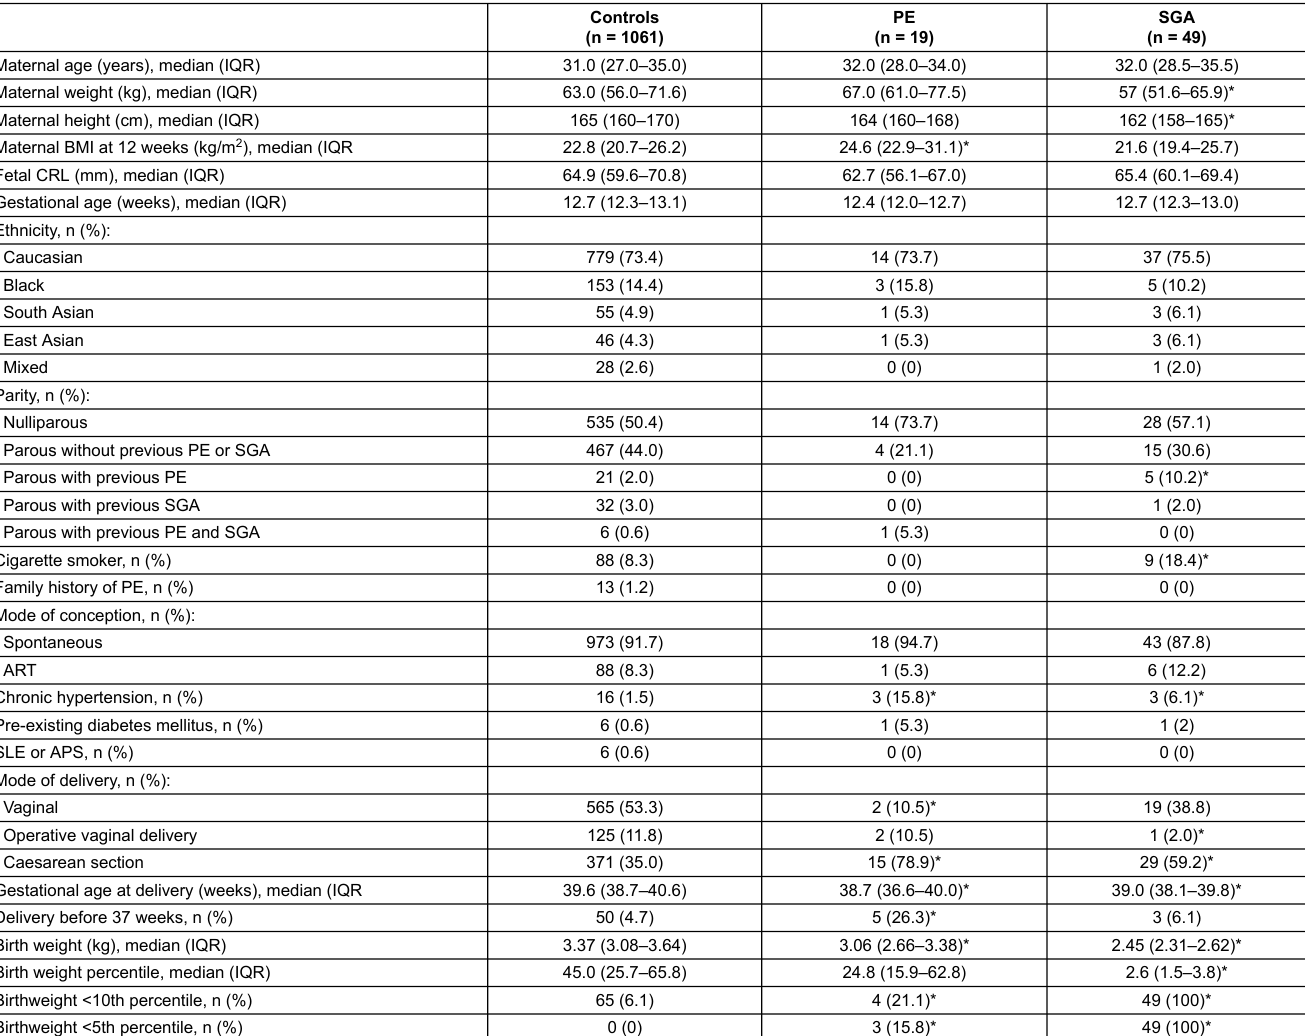
Table 1: Patients’ characteristics and pregnancy outcome of our study population divided into uneventful pregnancies (controls), pregnancies that developed preeclampsia and pregnancies that resulted in a small for gestational age infant (<5th percentile).